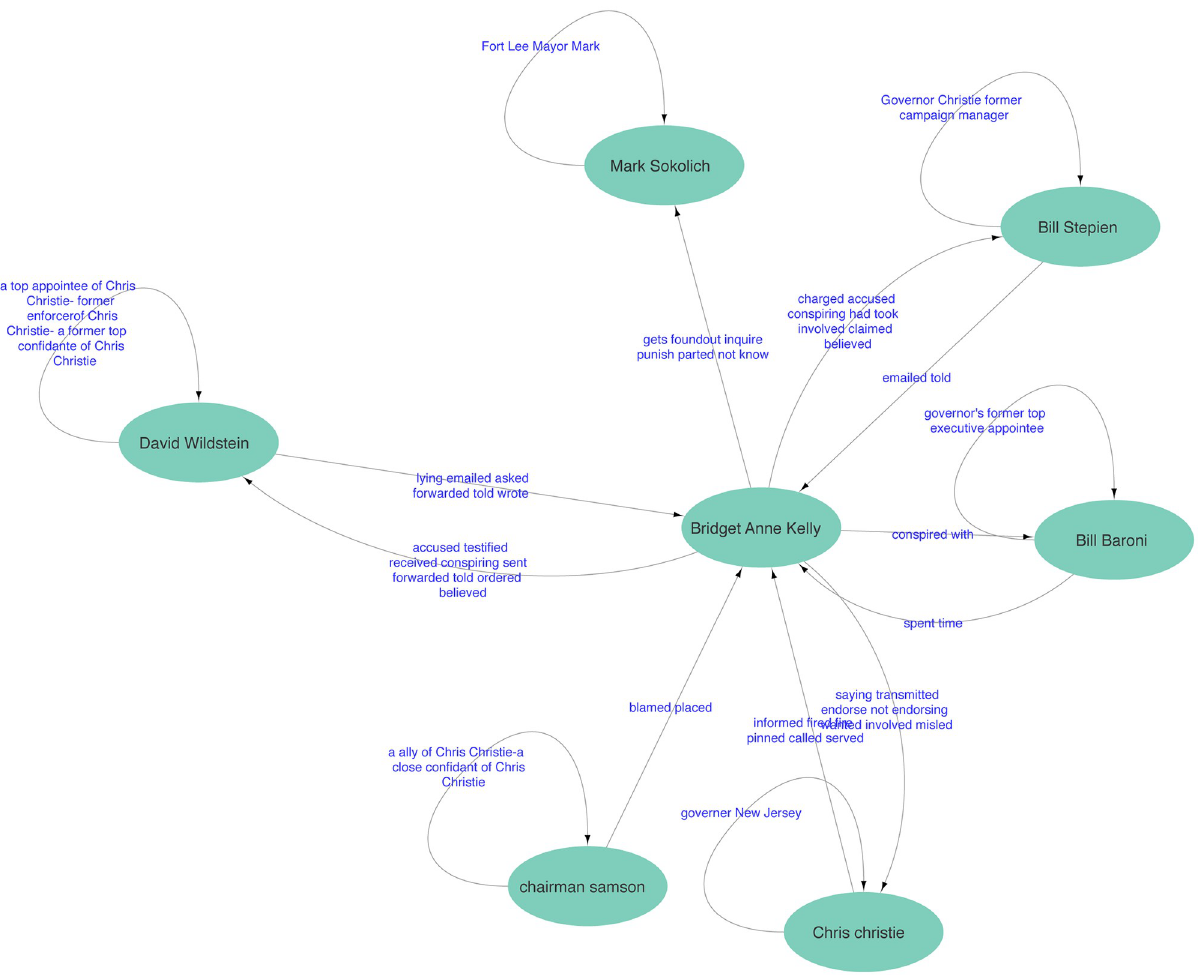
Fig 14. A subset of the ego network for Bridget Anne Kelly. The specific relationships between Kelly and other important named individuals are revealed in this ego network subgraph as determined both by their frequency and centrality in the narrative network. For each named entity, we added a self-loop edge labeled with automatically derived descriptions of the entity. These relationships show the endemic nature of the Bridgegate conspiracy: all actants are local to New Jersey politics. Since the edges are labeled with only the lead verbs appearing in the relationship phrases, the edge labels can be difficult to understand but, because we retain the original phrases, the relationship can be recovered. For example, the relationship “pinned” from Christie to Kelly can be linked to sentences such as: Critchley said evidence to support that claim is contained in interview summaries that accompanied a report commissioned by Christie’s office that pinned the blame largely on Kelly and Wildstein